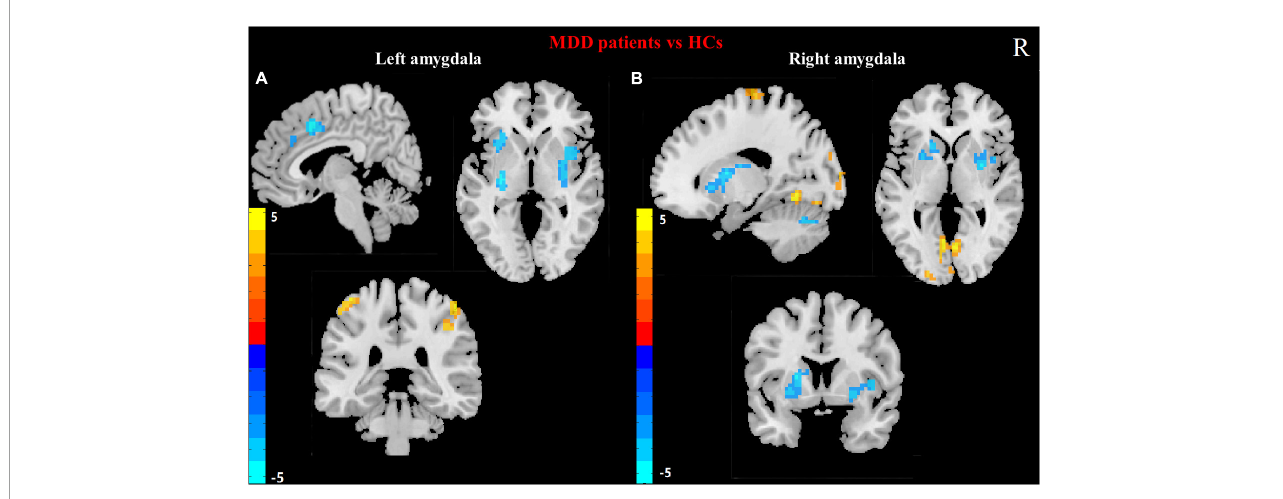
FIGURE1 Differences in left (A) and right (B) amygdala RSFC between MDD patients and HCs. (Two sample t -test, voxel- level p < 0.001, corrected by FWE). Color bar represents t -values. R: right.